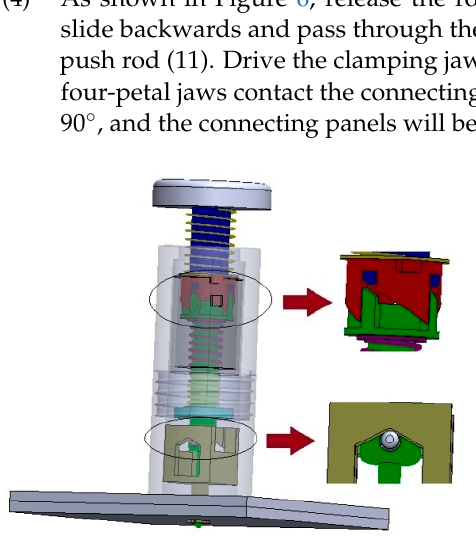
Figure 6. Schematic diagram of step 4.